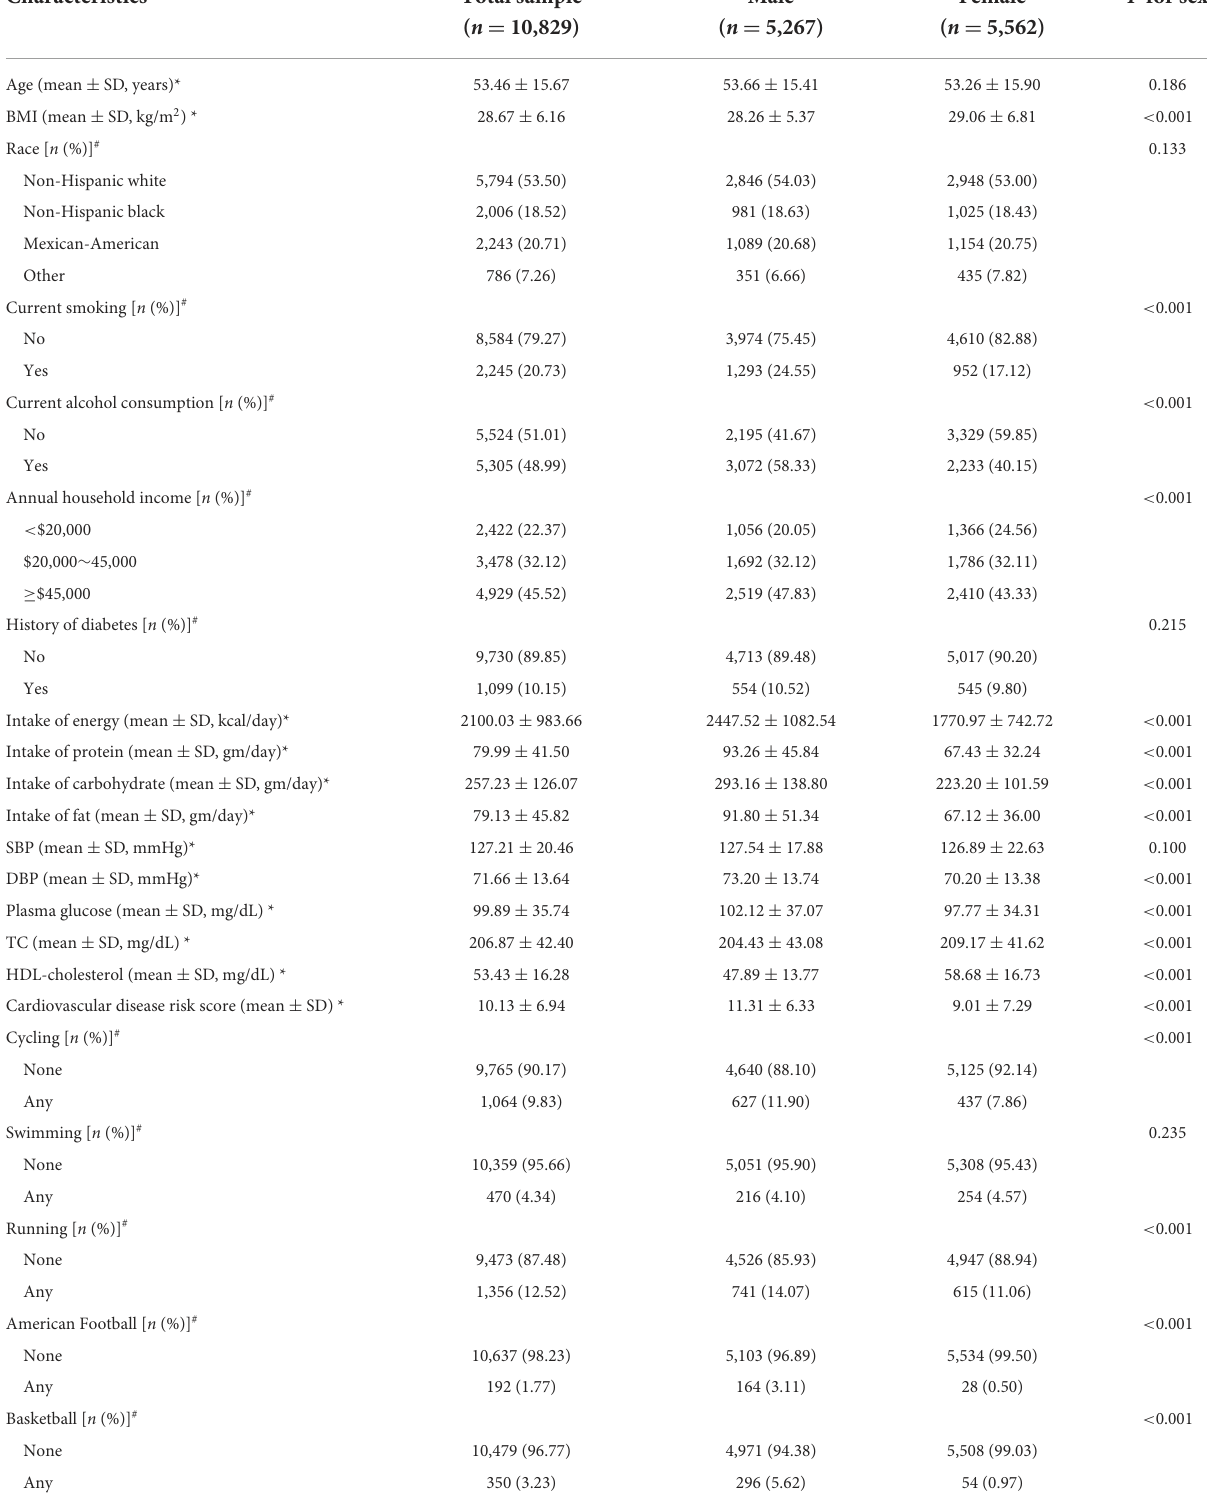
TABLE 1 Characteristics of all participants by sex.